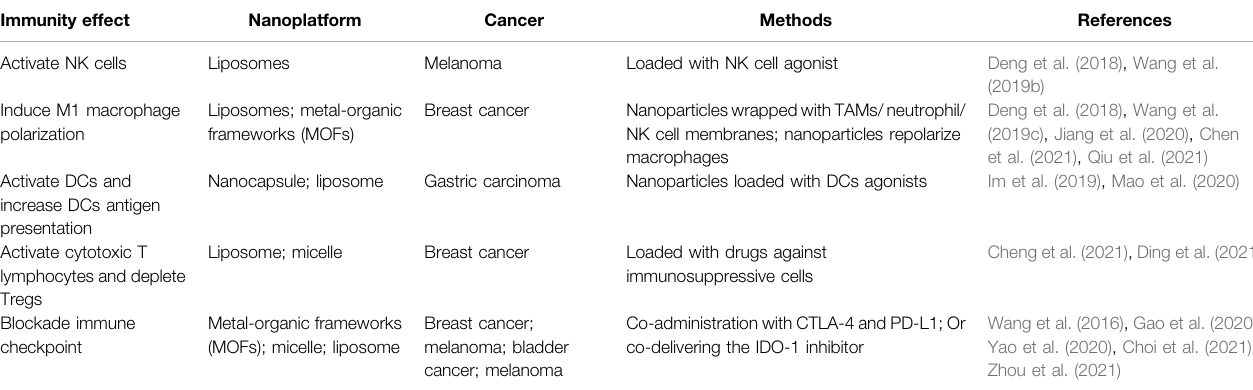
TABLE 2 | Summary of photodynamic therapy and immunotherapy combinatorial